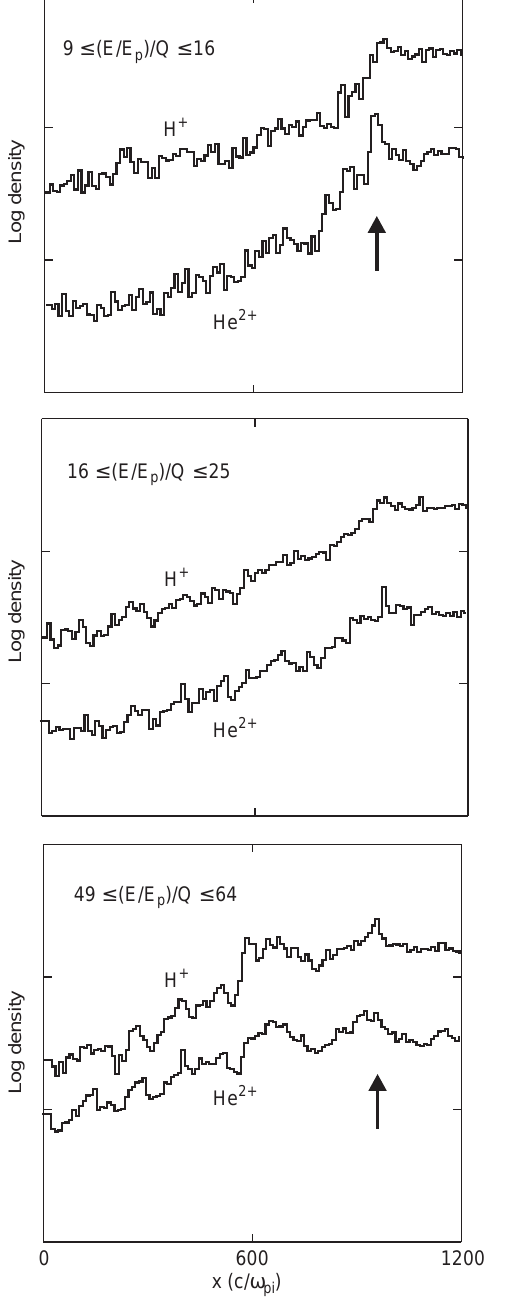
Fig. 11. Logarithm of the partial density of protons and alpha particles in three energy per charge bands versus distance. The position of the shock is indicated by an arrow